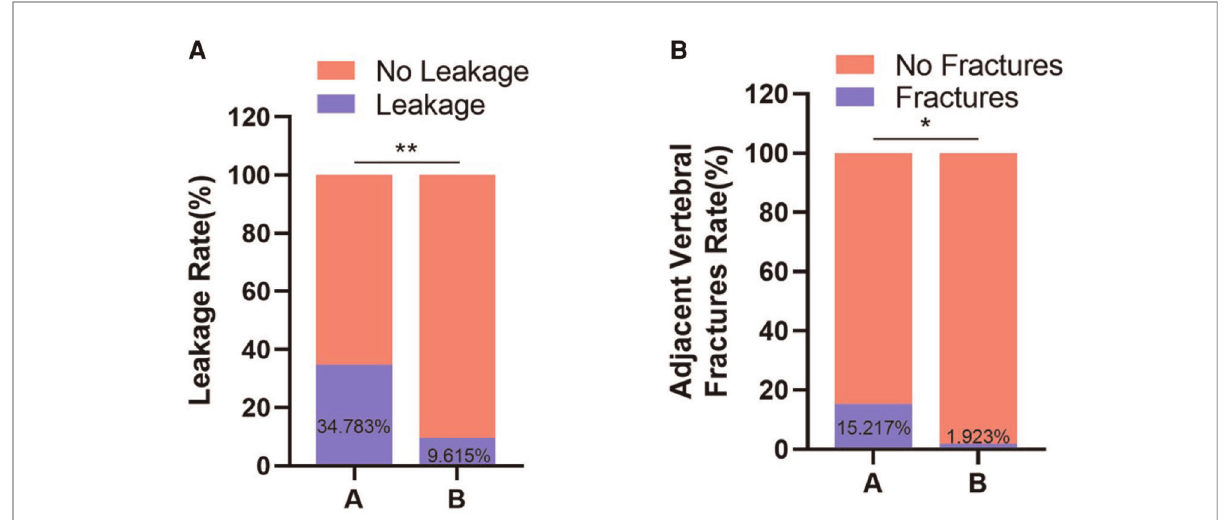
FIGURE 7 Postoperative complications. ( A ) Comparison of bone cement leakage rate between two groups. ( B ) Comparison of adjacent vertebral fractures between two groups. *, P <0.05 vs. control; **, P <0.01 vs.